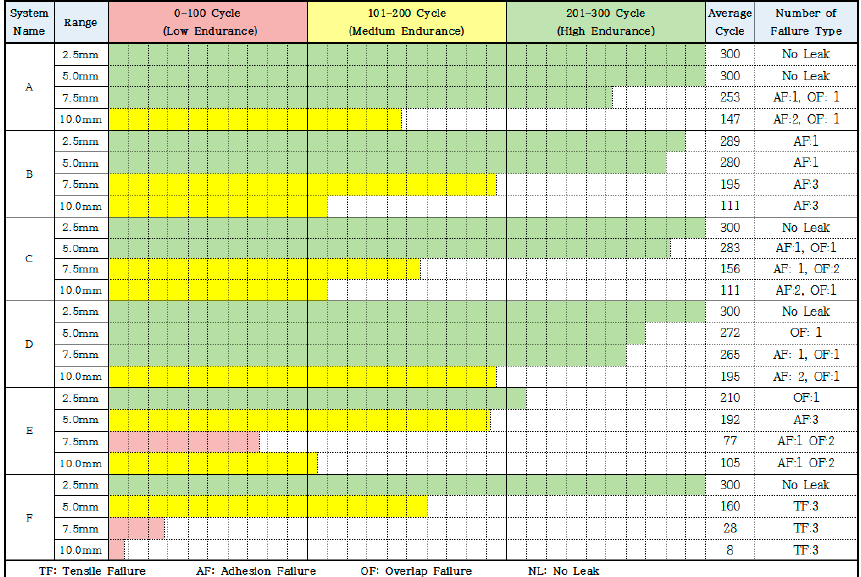
Figure 9. Endurance cycles of wet surface test specimens (Averaged).